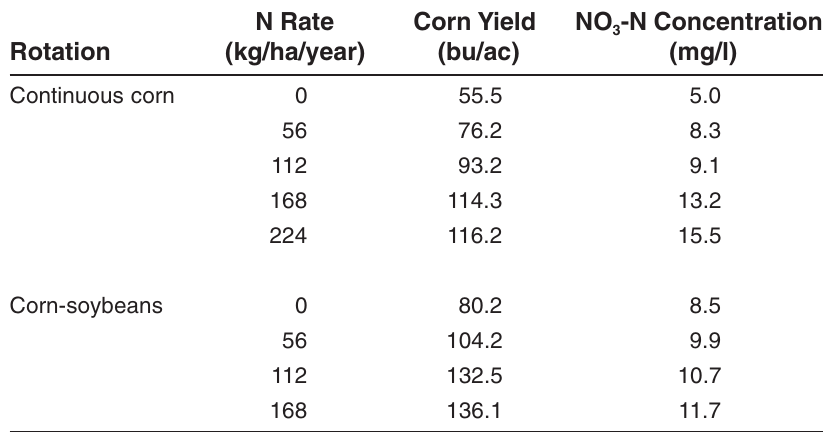
Corn Yields and NO -N Concentrations in 3 Tile Drainage as Affected by N Application Rate